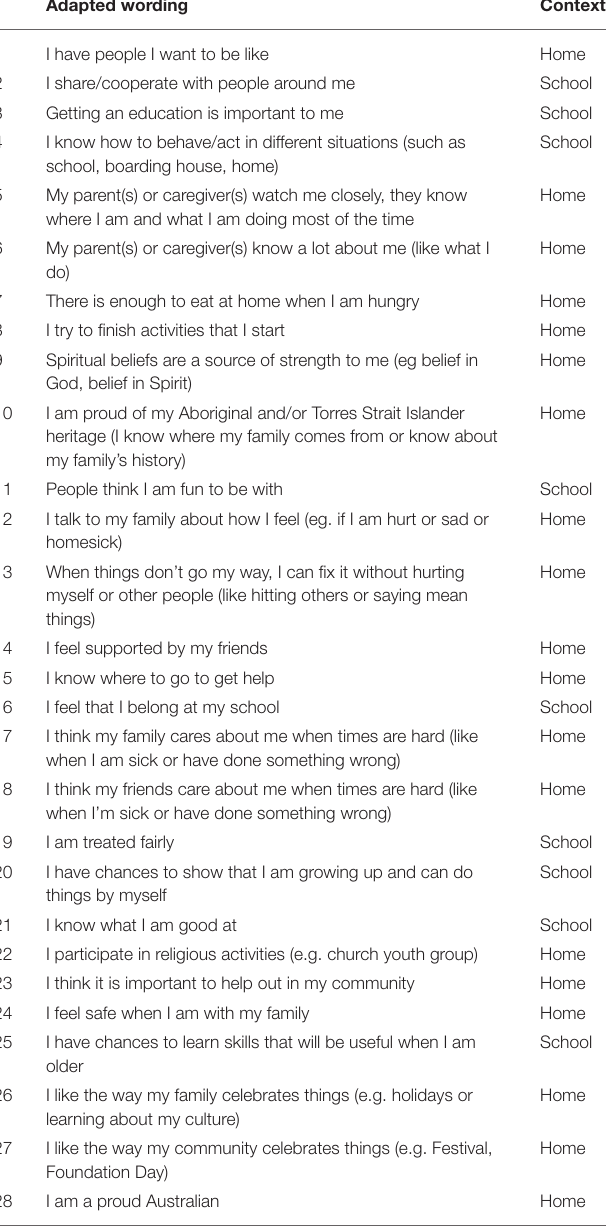
TABLE 2 | Adapted CYRM-28 scale for Australian Indigenous boarding school students. Adapted wording